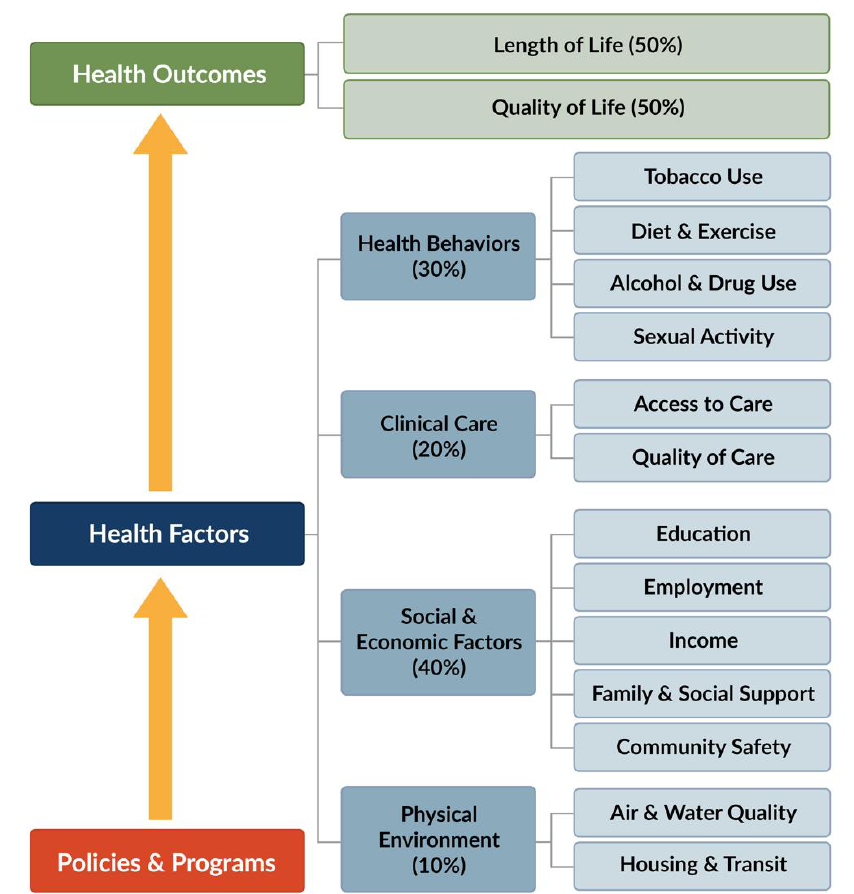
Figure 1. The conceptual framework outlining the social determinants of population health [7]. Country Health Rankings model ©2014